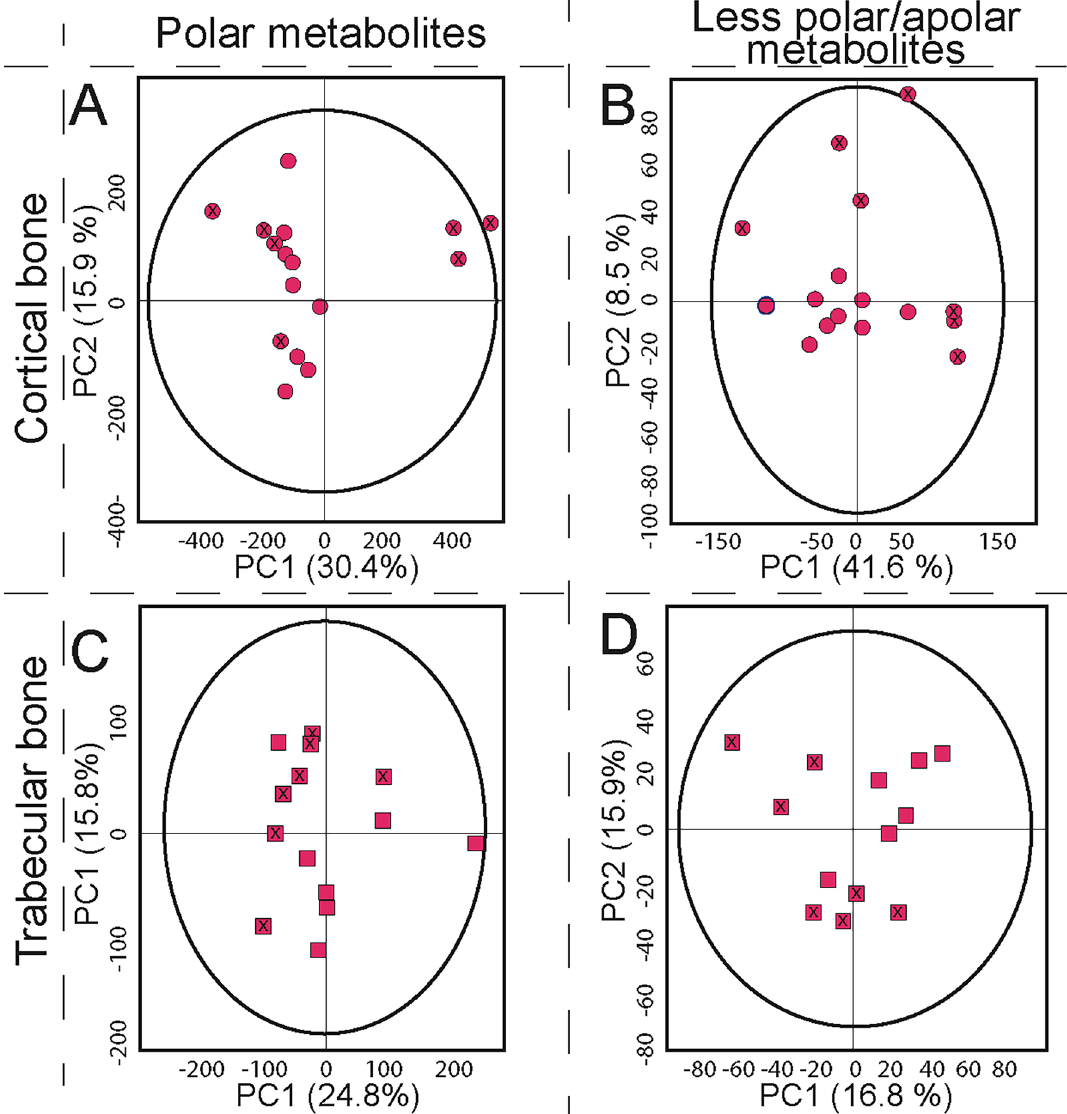
Figure 7. Principal component analysis of the untargeted metabolomic tests of femora, comparing an affected group with a control group using cortical and trabecular samples from human osteoarchaeological remains in a UPLC-IM-TOF-HRMS ESI positive mode platform. ( A ) Polar metabolites in cortical bone (HILIC) R 2 (cum):0.836, Q 2 (cum):0.621, N = 17, 1629 variables; ( B ) Less-polar/apolar metabolites in cortical bone (C18) R 2 (cum):0.655, Q 2 (cum):0.442, N = 17, 665 variables; ( C ) Polar metabolites in trabecular bone (HILIC) R 2 (cum): 0.707, Q 2 (cum): 0.393, N = 14, 1395 variables; ( D ) Less-polar/apolar metabolites in trabecular bone (C18) R 2 (cum):0.472, Q 2 (cum):0.0944 N = 14, 312 variables. X-Dots represent affected individuals in cortical bone. Dots represent individuals from the control group in cortical bone. X-squares represent affected individuals in trabecular bone. Squares represent individuals from the control group in trabecular bone. Ellipses indicate 95% of confidence for the PCA model. The explained variances of selected principal components are shown in